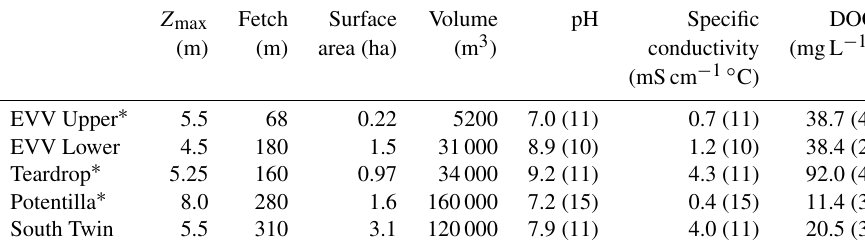
Sample size is in parentheses. ∗ Can also be found in Cadieux et al. (2016).